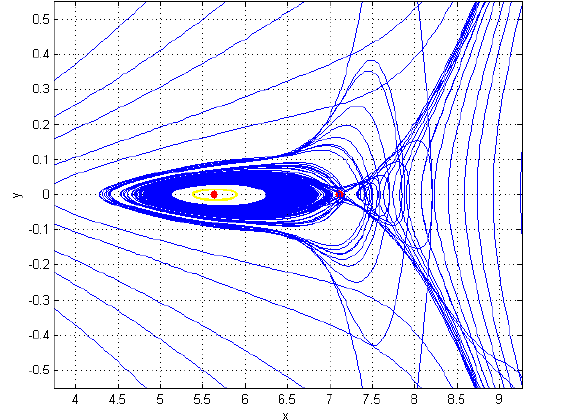
Fig. 1. Phase plane trajectory diagram, where traveling wave velocity c=-1.371, traveling wave parameter